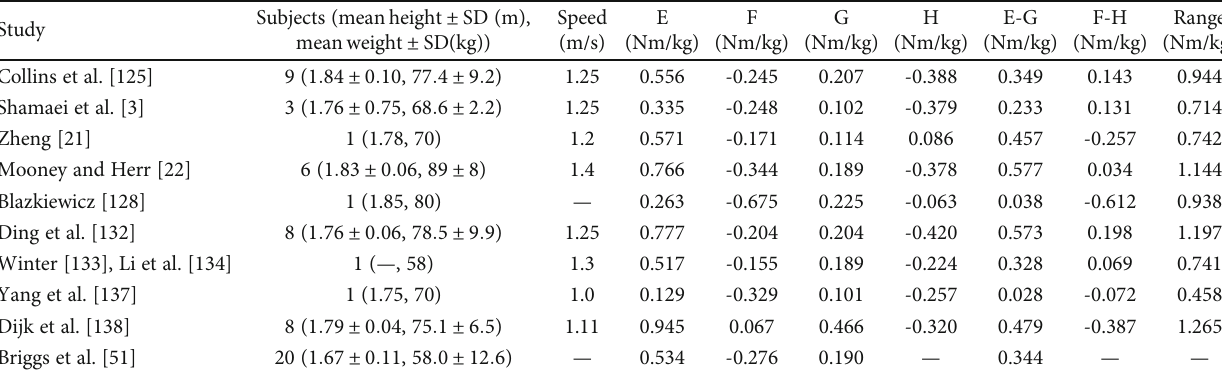
Table 2: Overview over the experimental results of knee moment for normal walking.